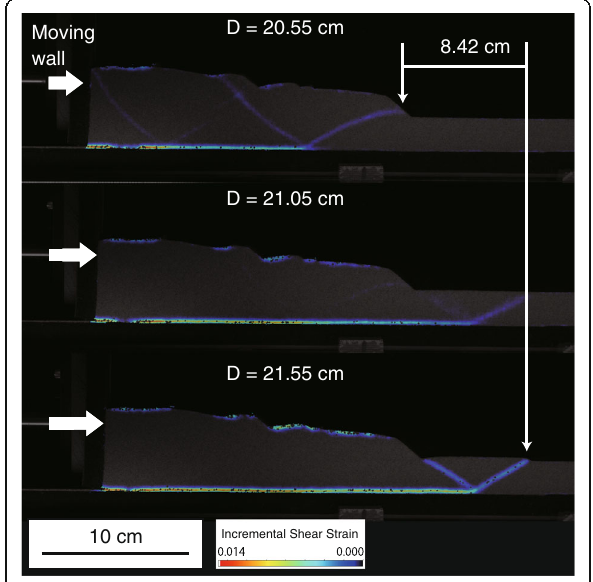
Fig. 3 Deformation timeline with convergence of flat basement reference model (EXP 1). The shortening (D) increases from the top to the bottom. The incremental shear strain becomes larger in the order from blue to red in the color reference. Incremental shear strain indicates not absolute magnitude, but